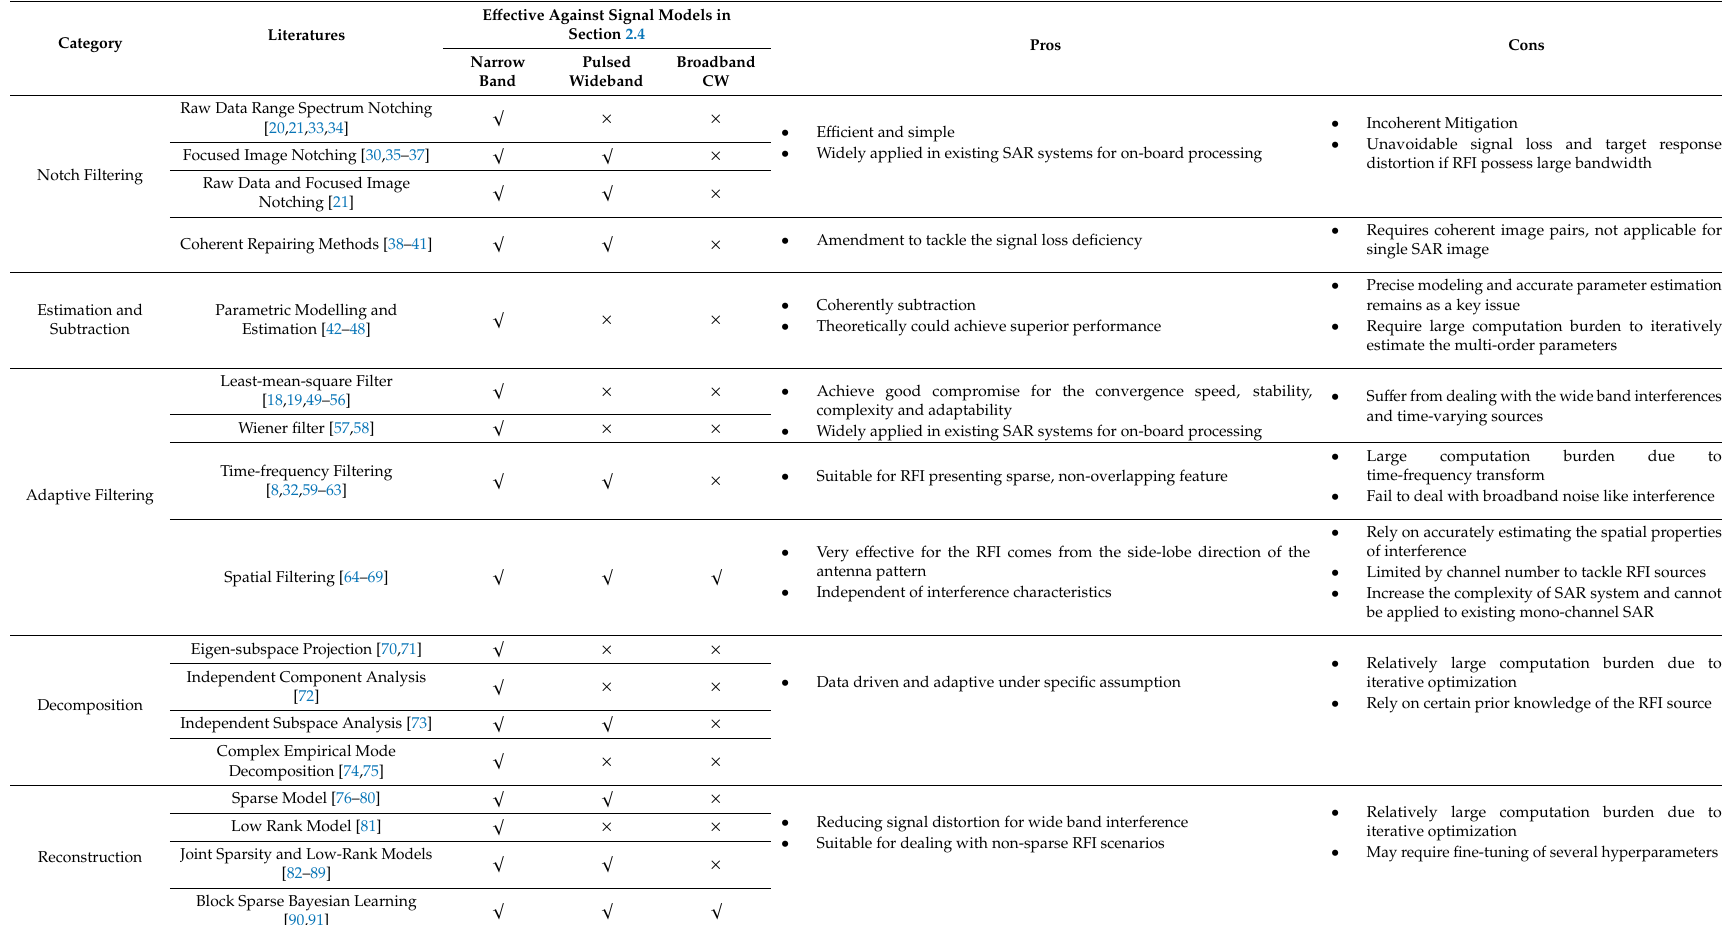
Table 2. Overview comparison of current state-of-the-art RFI mitigation techniques for